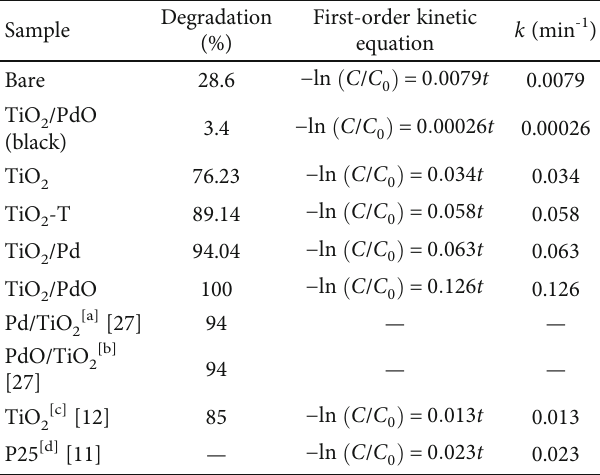
Table 3: Photocatalytic degradation activity for TiO TiO /Pd, and TiO /PdO and previously reported photocatalysts 2 2 for Rh B degradation under visible light irradiation.